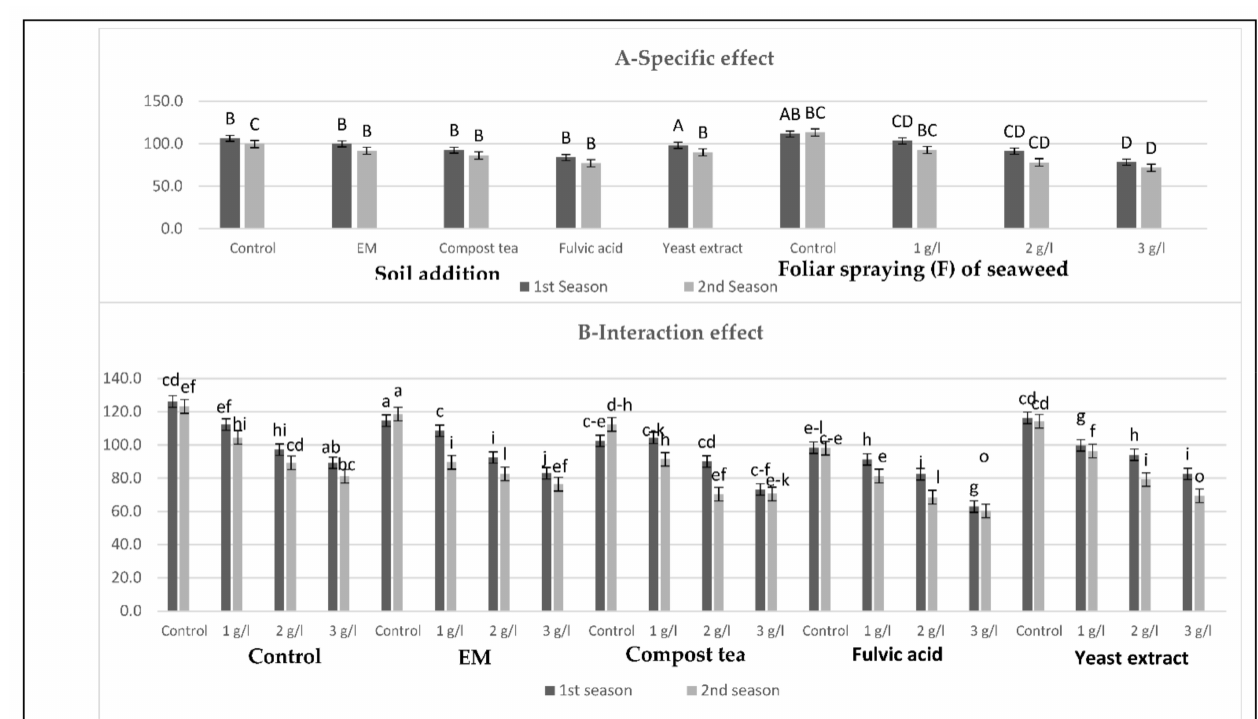
Figure 4. ( A , B ) Effects of soil addition of EM, compost tea, fulvic acid, yeast extract, and foliar spray with seaweed extract on the abscisic acid (mg/100 g f.w) of sweet pepper plants during the 2019/2020 and 2020/2021 seasons. Specific effects are indicated with uppercase letters and the interactions are indicated with lowercase letters, unless otherwise mentioned, according to Tukey’s multiple range test (TMRT) at p ≤